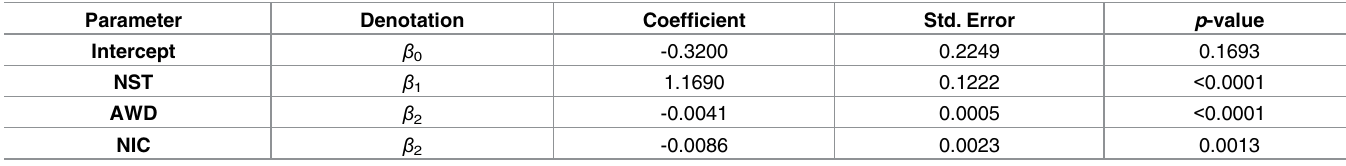
Table 5. Coefficients and std. errors for the regression model a